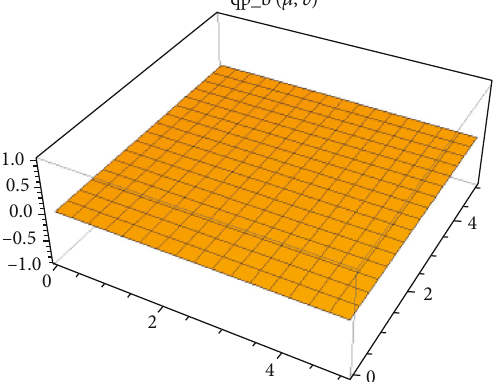
Figure 3: 3-D view. The plane in yellow represents the quasi- partial b -metric space de fi ned by qp , v Þ = u + v when u ≠ v for all u , v ∈ X